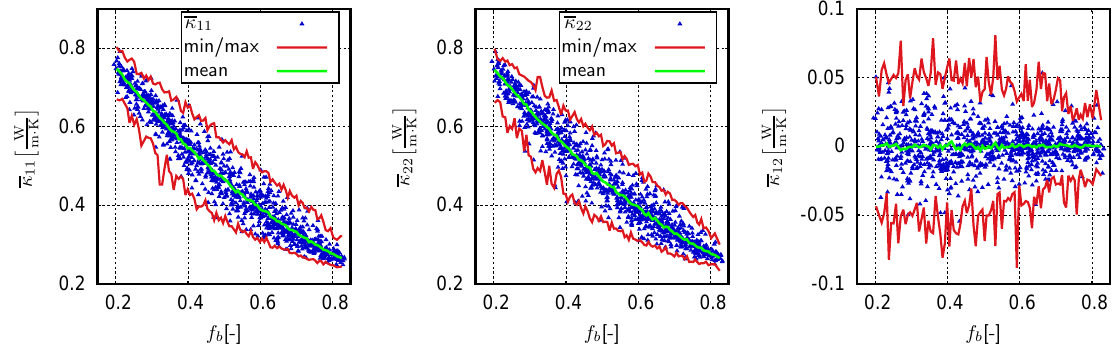
Figure 4. The range of each κ entry computed with 15,000 microstructures of the mixed set is shown. Only 1000 discrete values are shown in each